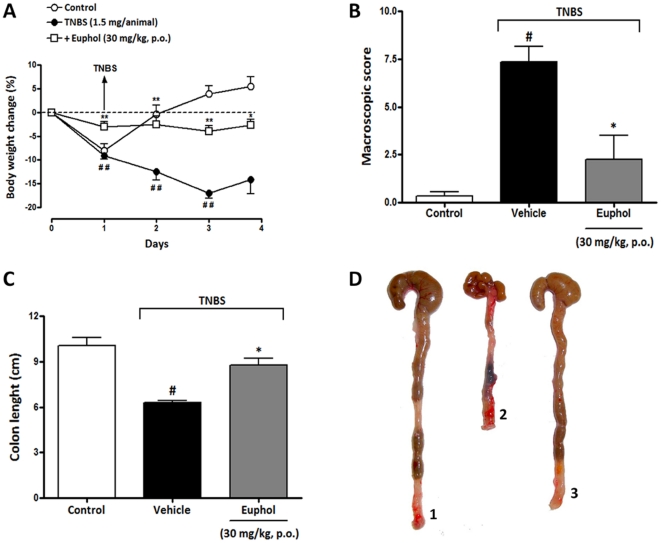
Therapeutic treatment with euphol protects mice against TNBS-induced acute colitis.Mice were given 100 µL of the TNBS (in 35% ethanol) and after 24 h, treated with euphol (30 mg/kg, p.o.). (A) The time-course of body weight changes on day 3 after TNBS-induced colitis. (B) Macroscopic score; (C) colon length after TNBS-induced colitis. (D) Representative photograph of colons from day 3 after the induction of TNBS-colitis. 1, Control healthy mice; 2, TNBS-treated (only vehicle administration); 3, TNBS plus euphol (30 mg/kg, p.o.). Each column represents the mean ± S.E.M. of 8 to 10 mice per group and is representative of two independent experiments. #P<0.05 vs. control healthy group (non colitic); *P<0.05 vs. TNBS-treated group. Vehicle corresponds to 5% Tween 80 in saline 0.9% NaCl.